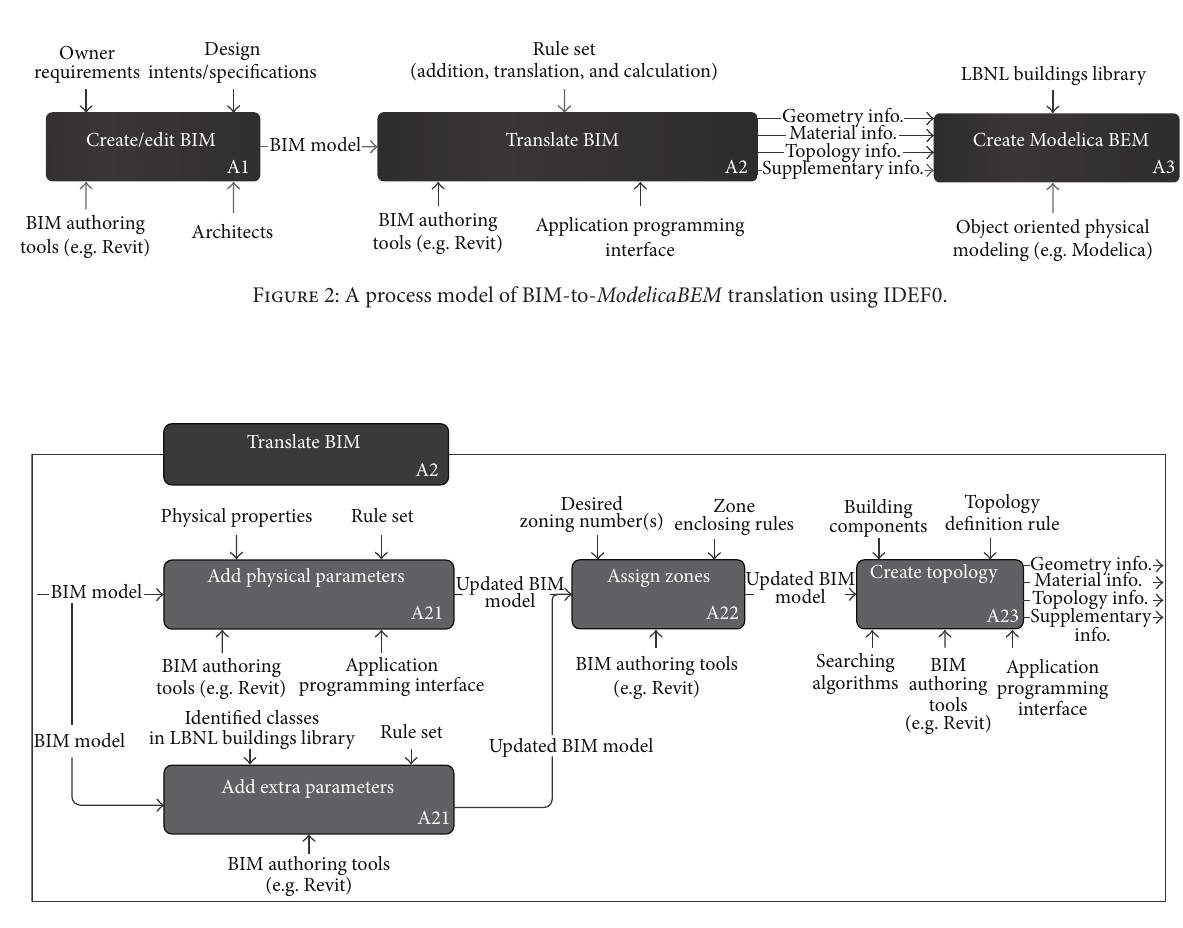
Figure 3: Detailed process model of translate-BIM activity to represent required data